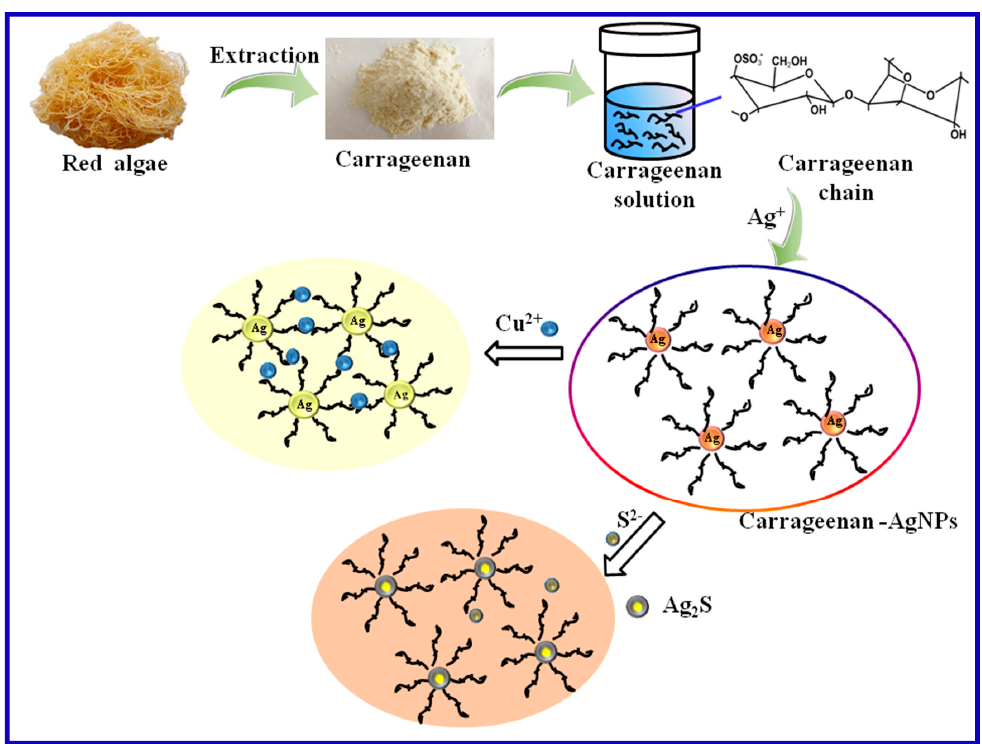
Scheme 1. Schematic illustration of the preparation of carrageenan-AgNPs and its application in the detection of Cu 2 + and S 2 − detection of Cu 2+ and S 2 − .